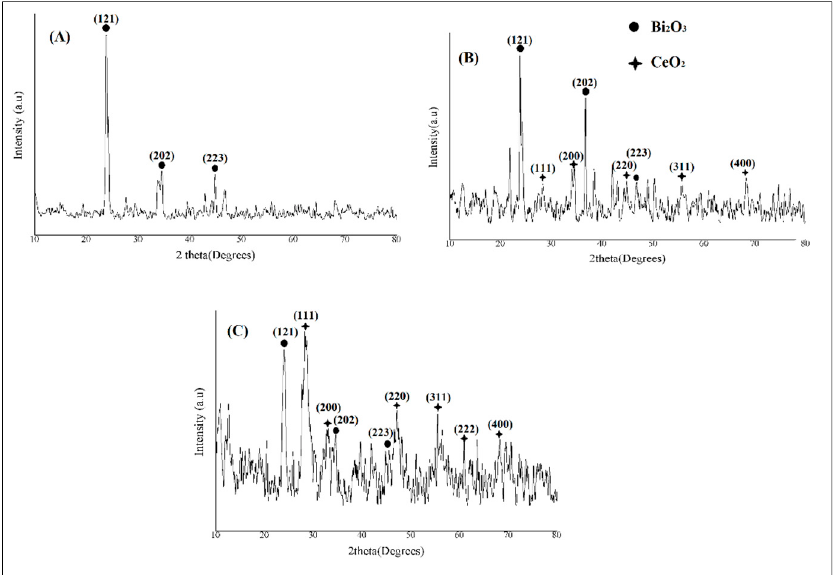
Figure 4. XRD pattern of ( A ) bismuth oxide Bi 2 O 3 (NC1), ( B ) Bi 0.8 Ce 0.2 nanocomposite oxide (NC2), ( C ) Bi 0.5 Ce 0.5 nanocomposite oxide (NC3).